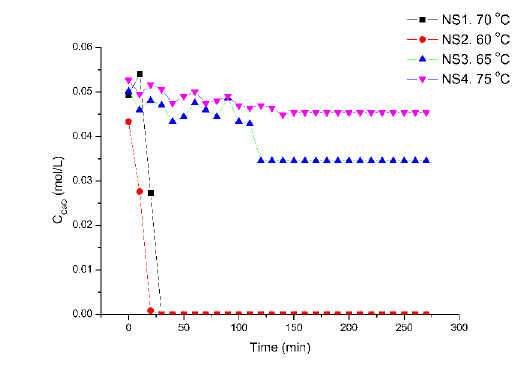
Figure 9. Kinetic experiments conducted with soot as the silica source. The lines are guides for the eye.